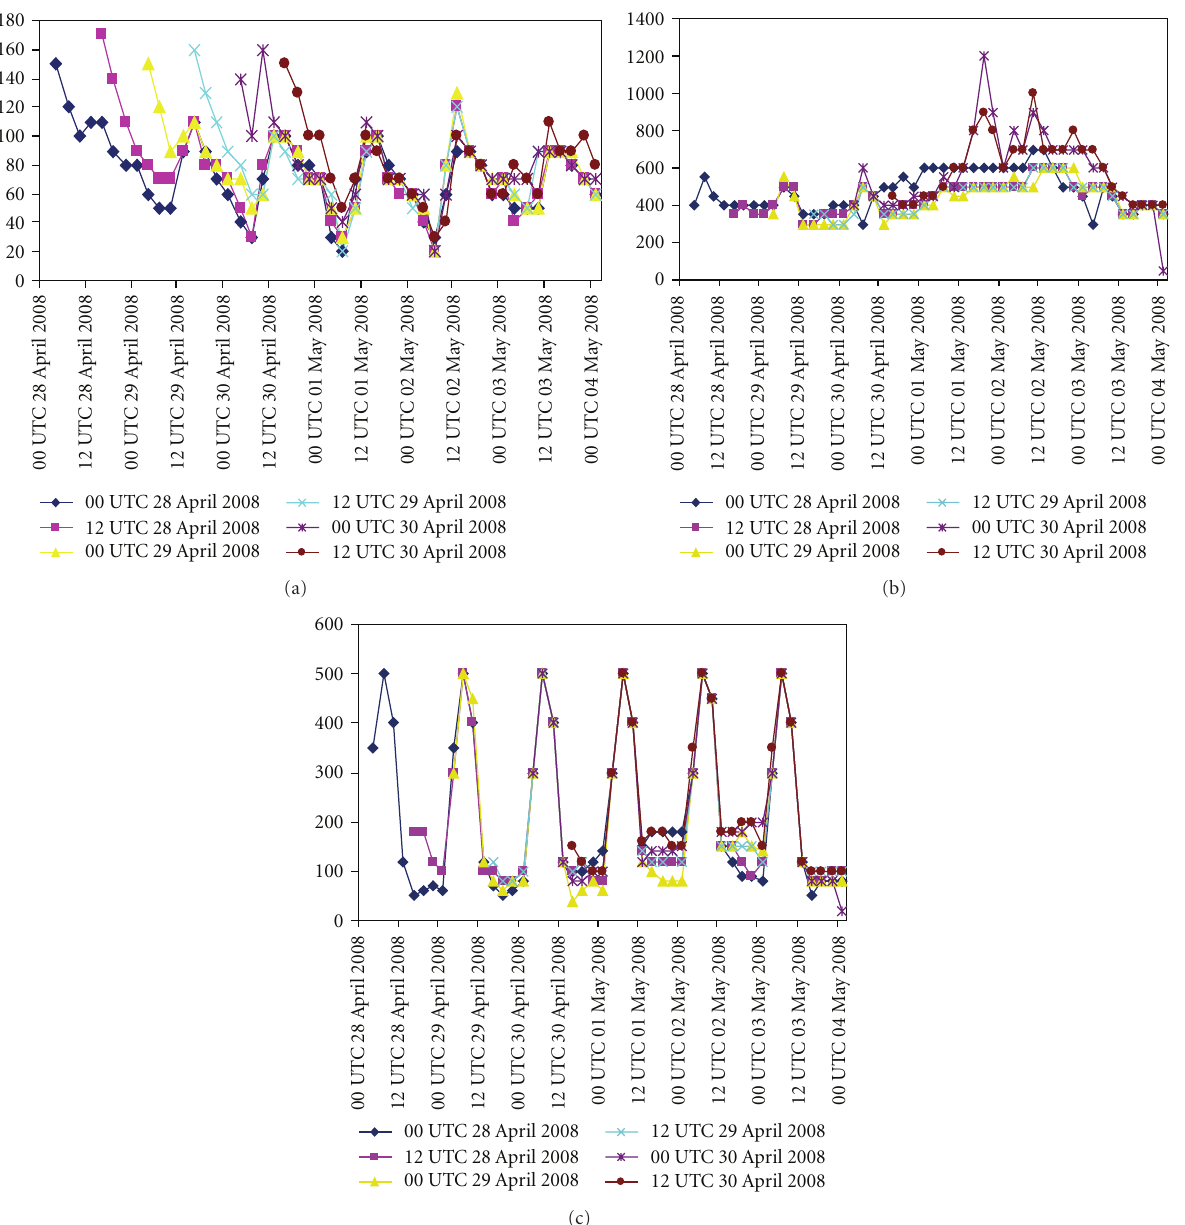
Figure 9: Time series of model-simulated (a) ground heat flux (Wm − 2 ), (b) latent heat flux (Wm − 2 ), and (c) sensible heat flux (Wm − 2 ) at di ff erent initial conditions with NMM land surface scheme. Table 3: Landfall point errors (km) and landfall time errors (hrs) with two optimum physics combination at di ff erent initial conditions. Landfall point error (km) with di ff erent land Landfall time error (hrs) with di ff erent Initial conditions surface